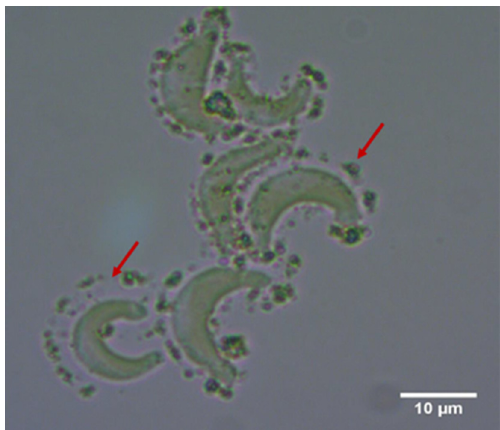
Figure 1. Nanoparticle attachment to transparent, sheath-like structures around algal cells (red arrows). This phase-contrast image (1000 × magnification) was captured after 3 h incubation with 100 mg / L CeO 2